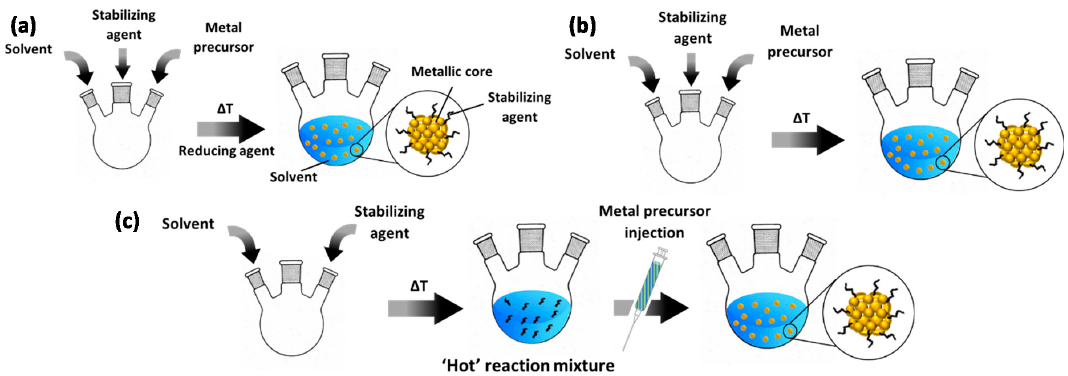
Figure 1. Common protocols for colloid synthesis: ( a ) chemical reduction; ( b ) thermal decomposition with precursor added in the initial step; ( c ) thermal decomposition via hot injection. The blue-green content of the syringe indicates that the metal precursor (green) is dissolved in the same solvent as the reaction vessel (blue). For ease of representation, the final step in the synthesis, i.e., cooling down of the reaction vessel, is not included.